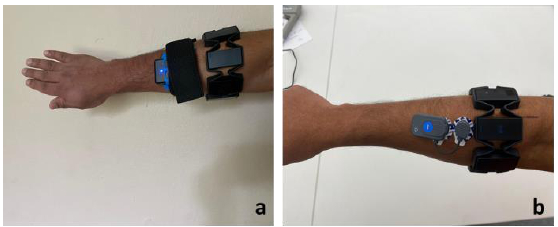
Figure 2. Position of conventional ( a ) inertial measurement unit IMU and ( b ) electromyography (EMG) along with armband sensor.